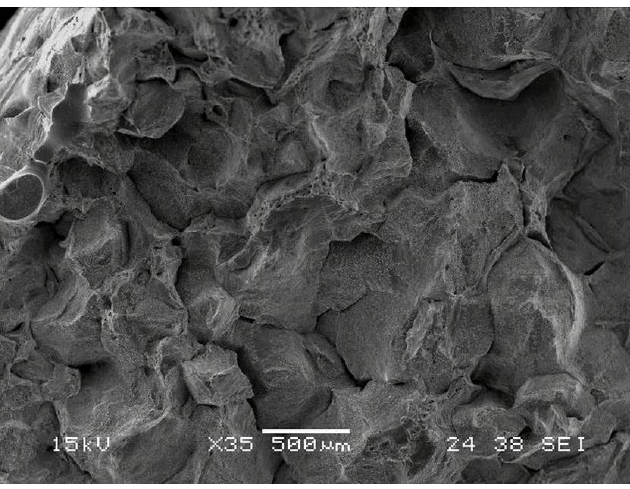
Figure 7. SEM image of fracture surface for the specimen tested at 800